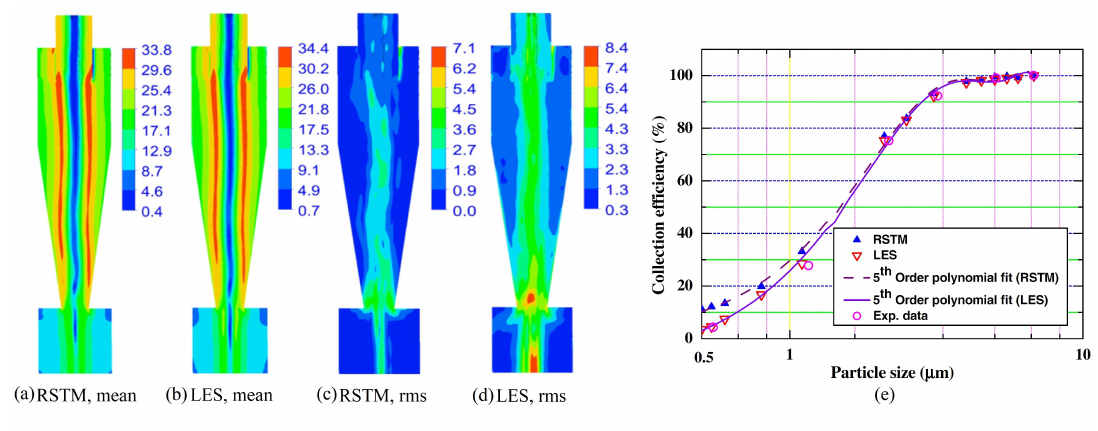
Figure 5. Comparison of predicted mean velocity profiles ( a , b ), rms velocities ( c , d ), and grade efficiencies ( e ) using the Reynolds stress transport model (RSTM) and large eddy simulation (LES) for a cyclone with a body diameter of 0.29 m and operating at ambient temperature and pressure [96]. The experimental data on separation efficiency are from [97]. Reproduced with permission from S. Shukla et al., The effect of modeling of velocity fluctuations on prediction of collection efficiency of cyclone separators; published by Elsevier,